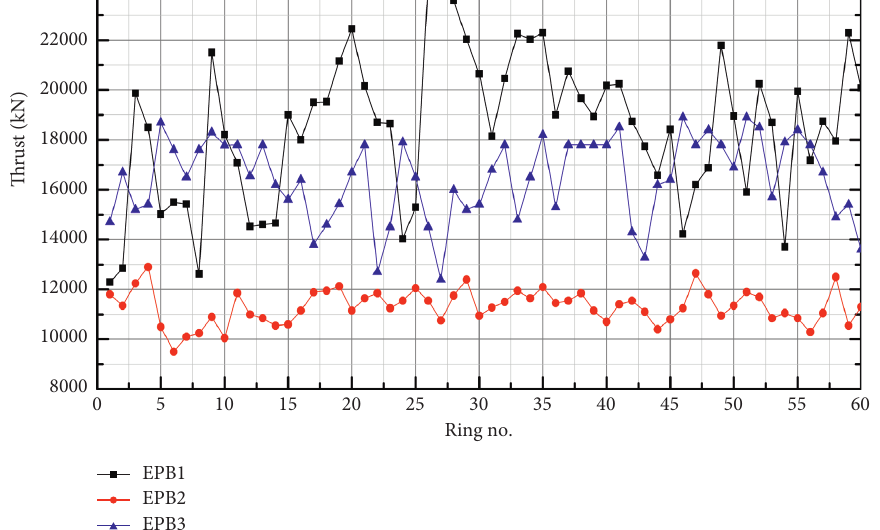
Figure 7: Thrust of the three